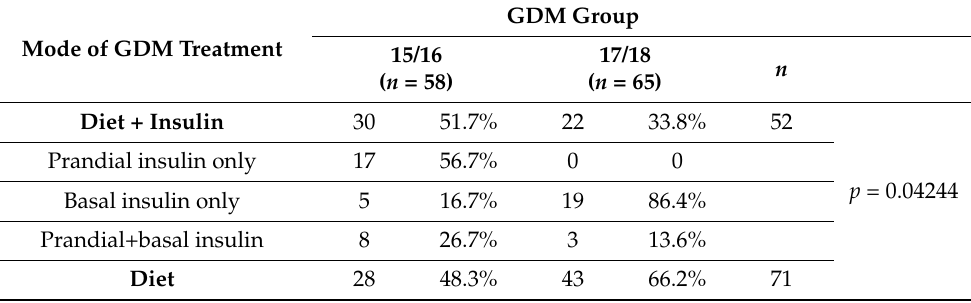
Table 5. Mode of treatment of gestational diabetes mellitus (GDM).